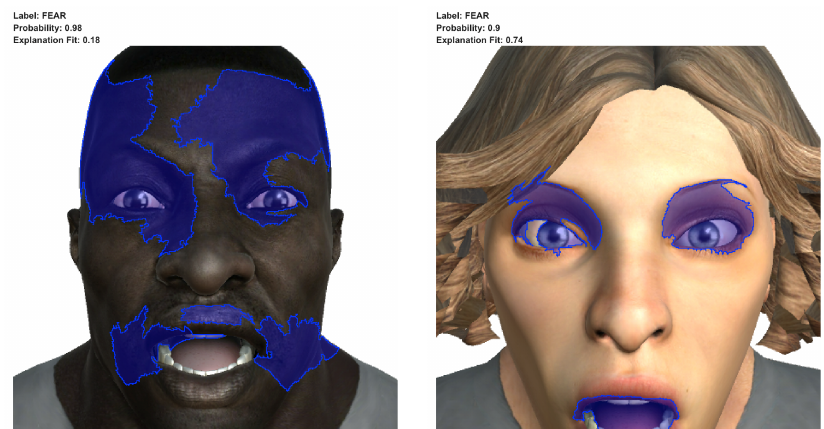
Figure 9. Results of applying LIME to the images of surprise incorrectly labelled as the emotion of